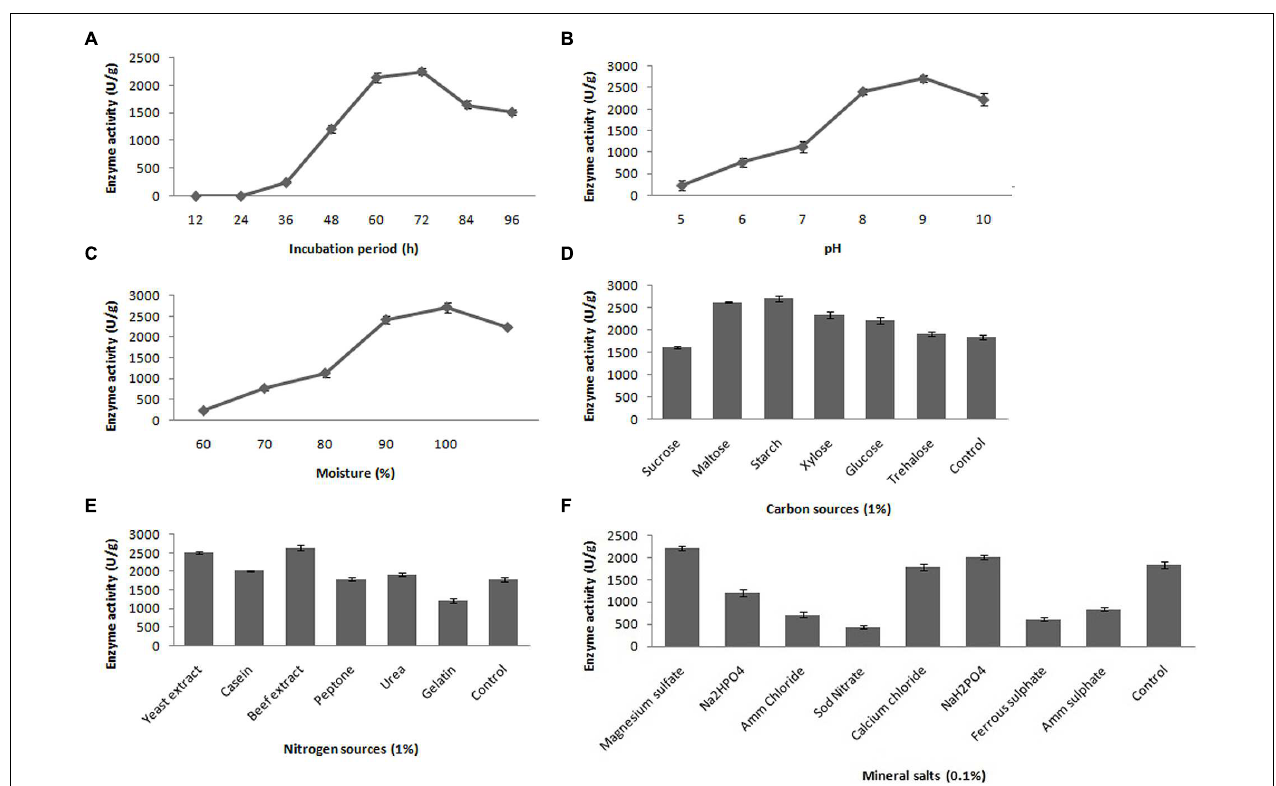
FIGURE 3 | Effect of incubation time (A), pH (B), moisture (C), carbon source (D), nitrogen source (E) and mineral salts (F) on fibrinolytic enzyme production. Error bar represents standard